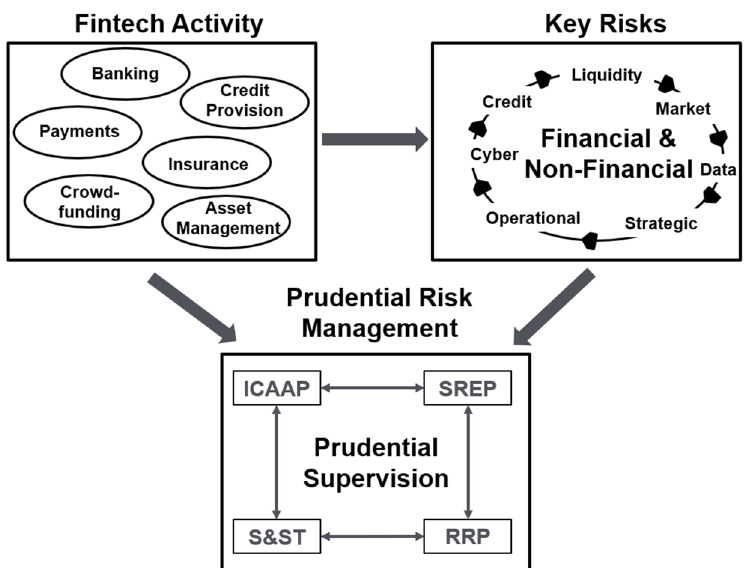
Figure 4. Fintech risks prudential risk management.